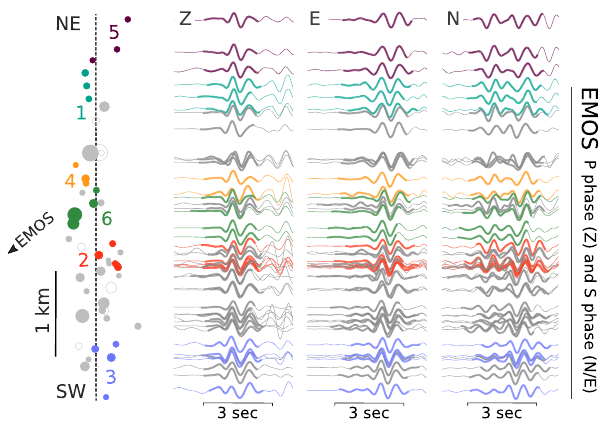
Fig. 6 Waveform similarity of relocated events. P and S waveforms (here shown for station EMOS) are very similar, even when fi ltered with a passband of 1 – 8 Hz. The signals change gradually along the SW – NE trending lineament (equivalent to pro fi le CD in Fig. 2a). By applying a waveform-based event similarity clustering algorithm, we fi nd six spatially separated clusters of events (color-coded, cluster numbering based on origin time of the fi rst clustered event); note that the clustering is not only based on the waveforms of the exemplary station EMOS, shown here, but also on several other stations. Waveforms are scaled by the maximum amplitude within the time window (bold) and aligned by the cross- correlation time shift to emphasize waveform